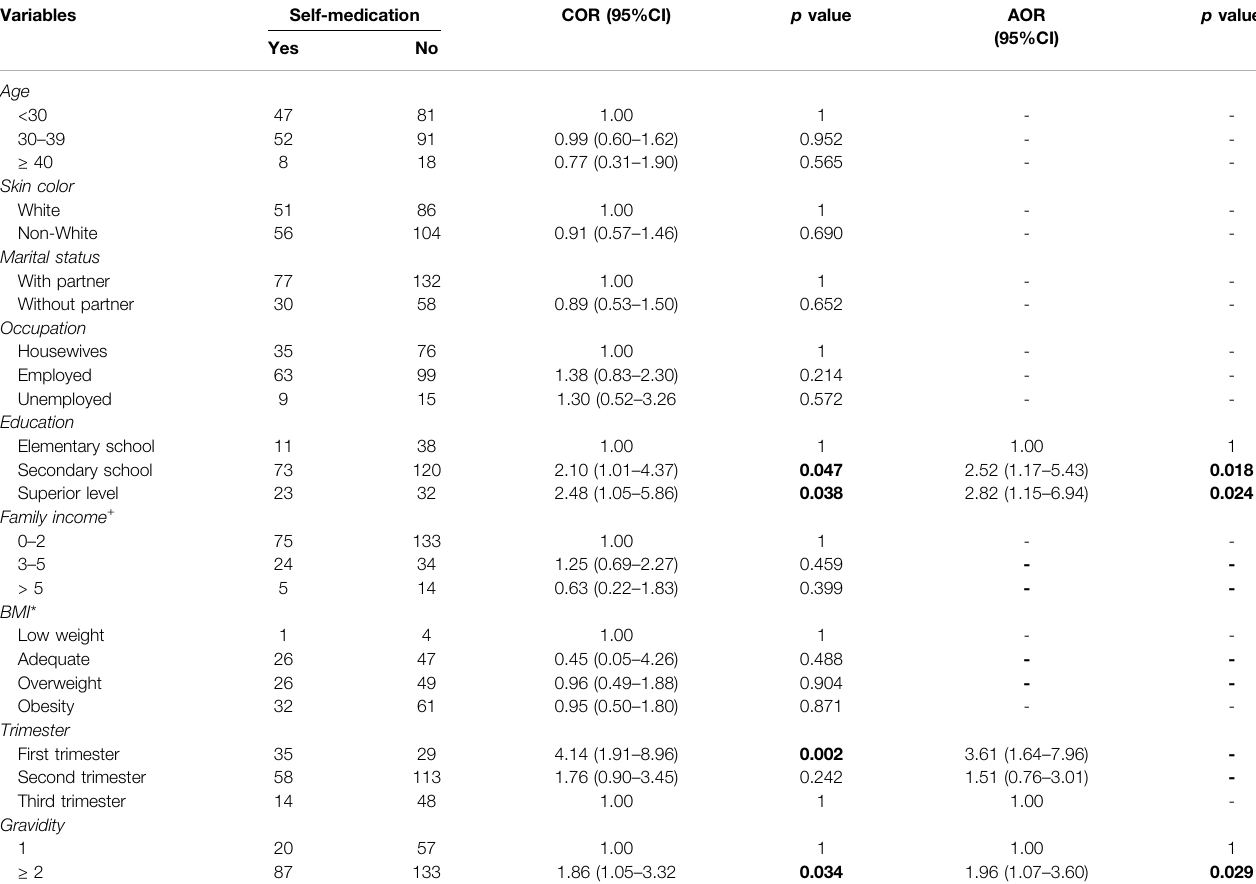
TABLE 4 | Univariate and multivariate logistic regression analysis of variables associated with self-medication during pregnancy ( n (cid:1)